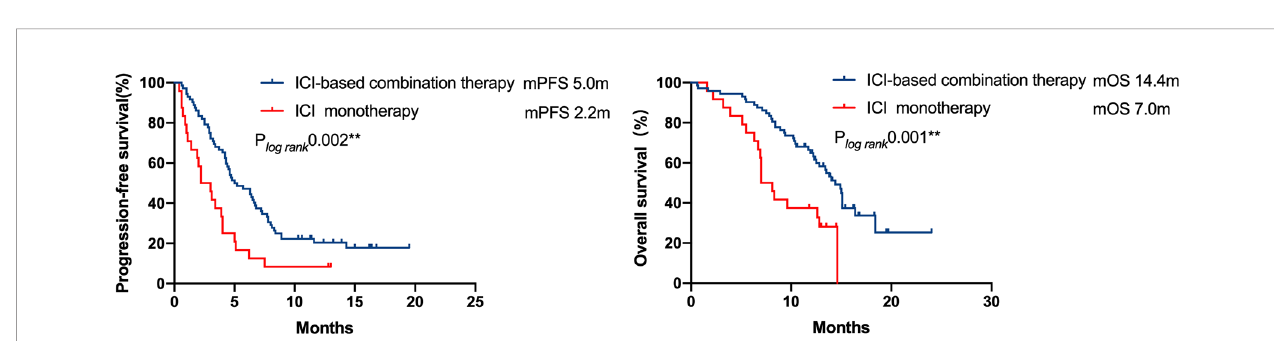
FIGURE 3 | Kaplan – Meier curves of progression-free survival and overall survival of patients who received ICI-based combination therapy versus ICI monotherapy. The ef fi cacy of ICI-based combination therapy was better than that of ICI monotherapy (mPFS 5.0months vs. 2.2 months, P = 0.002, mOS 14.4 months vs. 7.0 months, P =